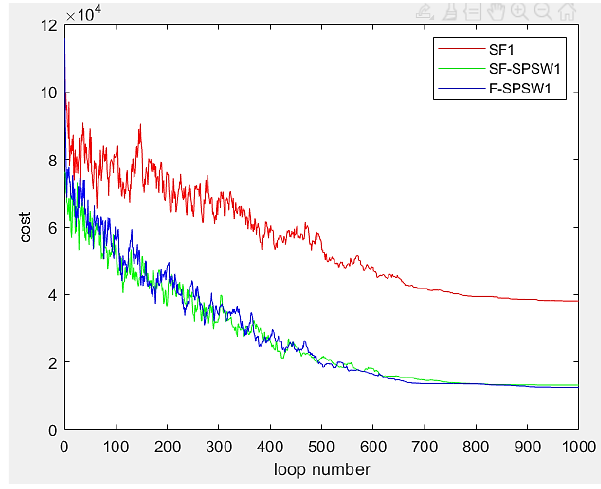
Figure 13. Convergence histories. The best costs of SF, SF-SPSW, and F-SPSW are USD 38,095, USD 13,179, and USD 11,221, respectively, and the resulting total weights are 14.4 tons, 5.3 tons, and 4.5 tons. The results show that for a structure with 15 m height, the total weight of SF is significantly more than that of SF-SPSW and F-SPSW, which is about 2.7 times larger than that of SF- SPSW, 3.2 times larger than that of F-SPSW, and the cost of SF is about 2.9 times higher than that of SF-SPSW and 3.4 times higher than that of F-SPSW.